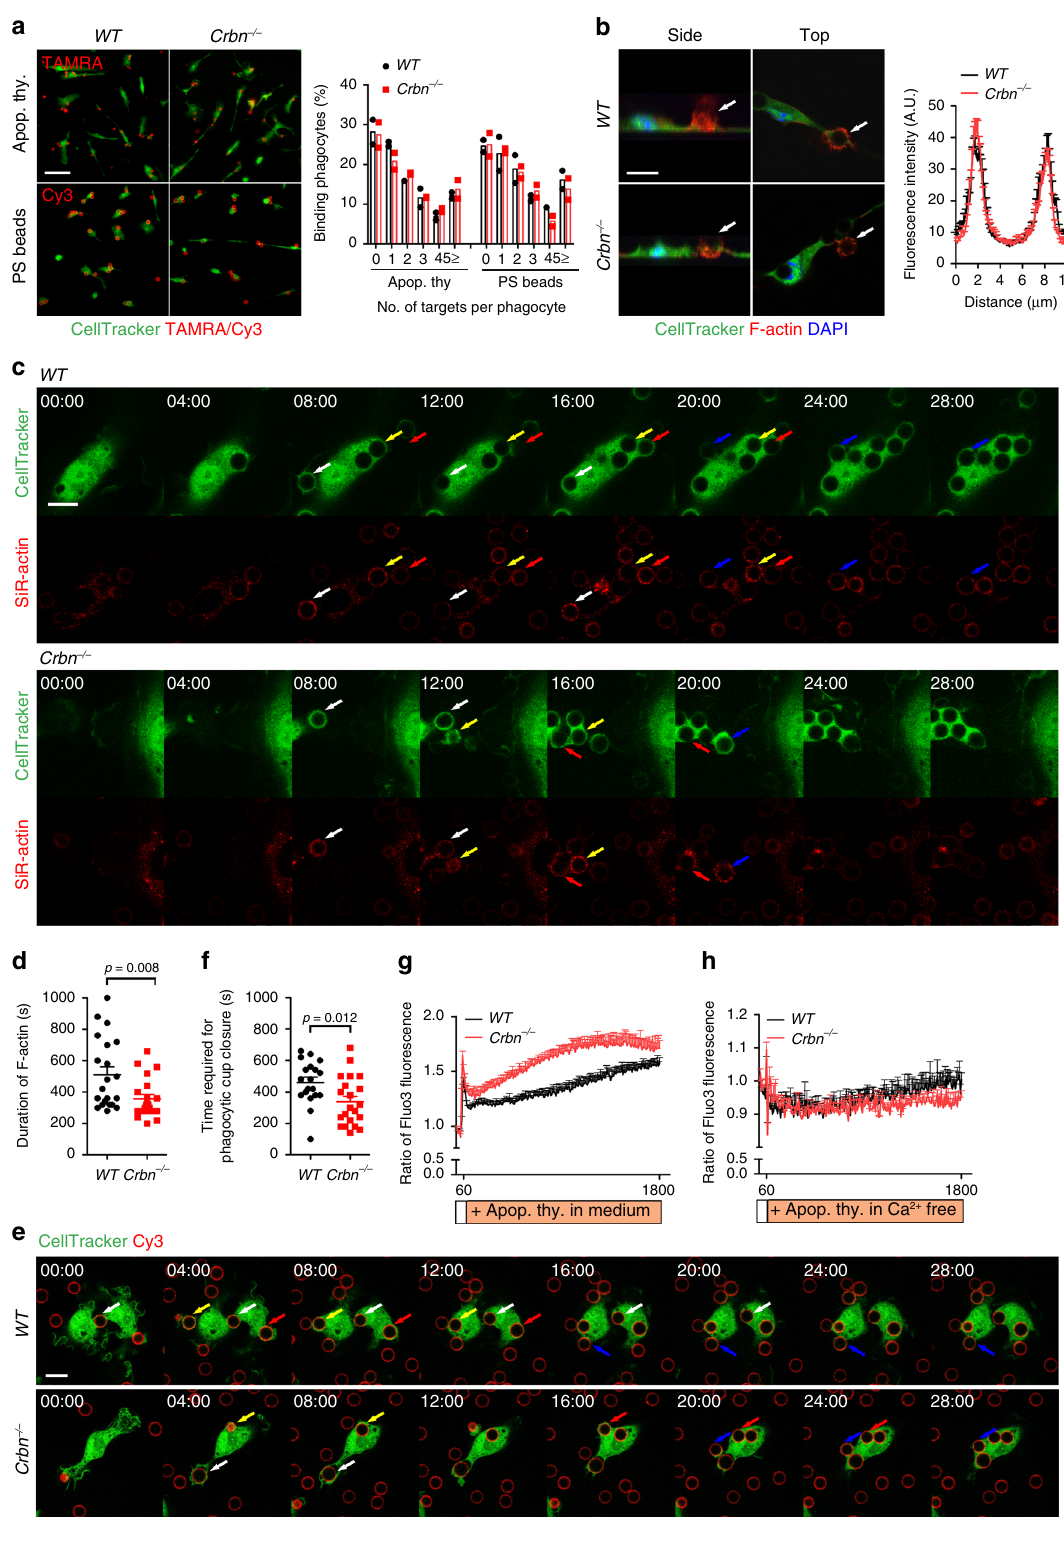
intracellular calcium level by blocking Mcu-mediated mitochon- drial calcium sequestration during efferocytosis, inhibited effer- ocytosis by WT BMDMs, but not by Crbn − / − BMDMs (Fig. 3h), suggesting that Drp-1-mediated calcium fl ux is not related to the effects of Crbn on efferocytosis. Taken together, these data imply that Crbn affects efferocytosis by modulating CRAC channel- mediated